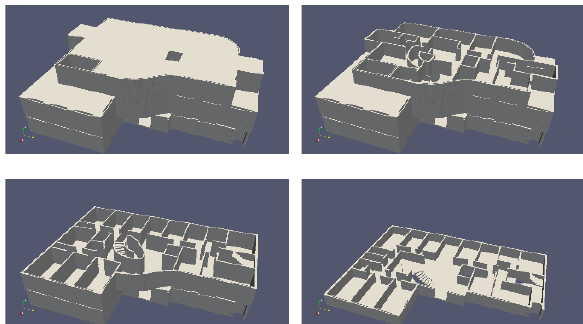
Fig 8: the entire building, including the roof (top left) as well as ‘cut-off’ models at three different heights, showing the layouts of the three